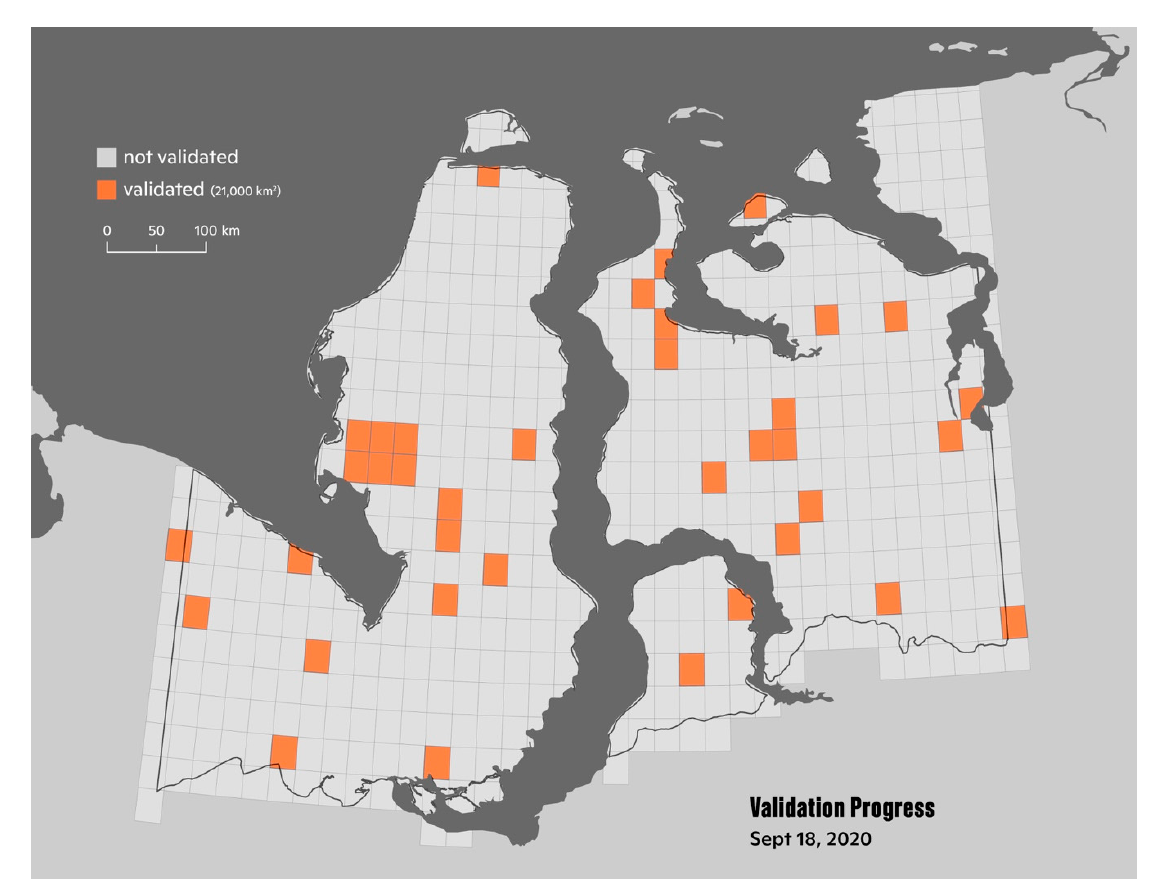
Figure A3. Distribution of fishnet cells across the study area (outlined in dark gray). Out of 604 fishnet cells within the study area, 37 (6.1%) were validated, accounting for 28,300 km 2 .